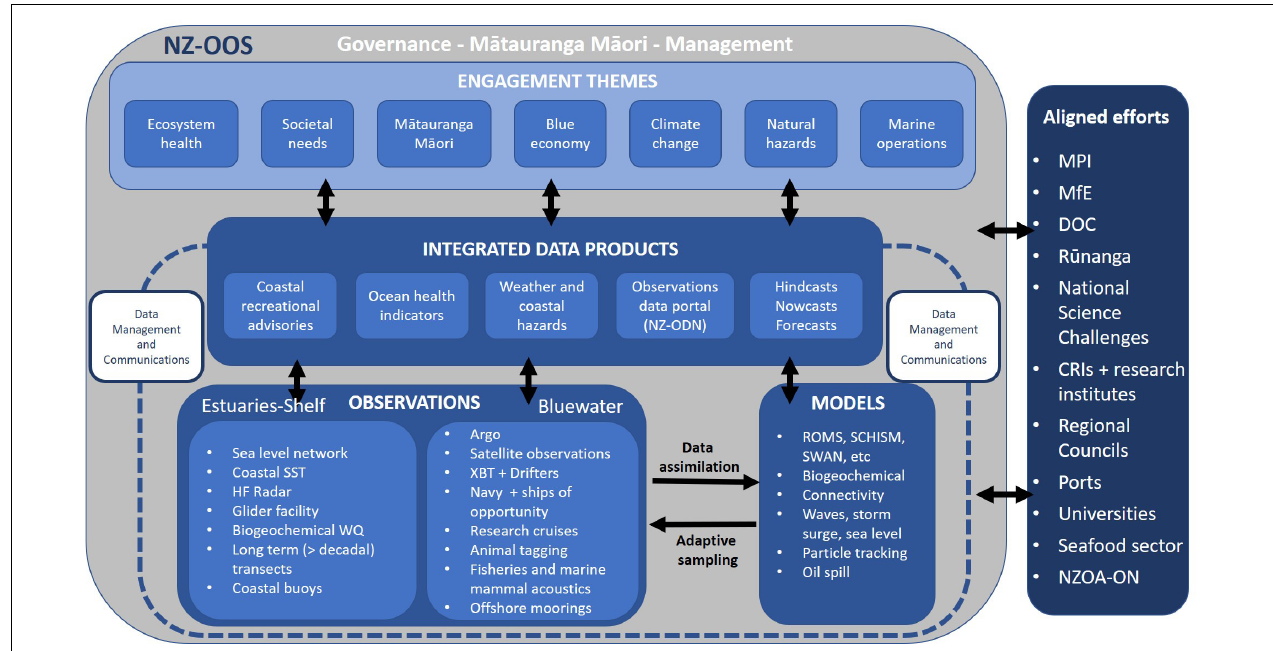
FIGURE 2 | Framework for the NZ-OOS building on existing efforts in NZ. The proposed structure illustrated has been adapted from that used for the Southeast Coastal Ocean Observing Regional